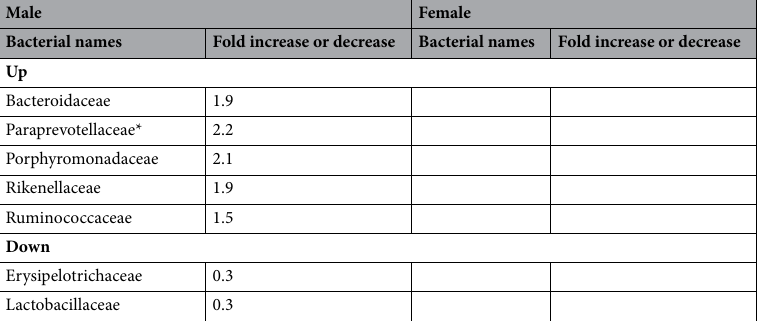
Table 1. Perturbed bacteria at the family level. *k_Bacteria; p_Bacteroidetes; c_Bacteroidia; o_Bacteroidales; f_Paraprevotellaceae.